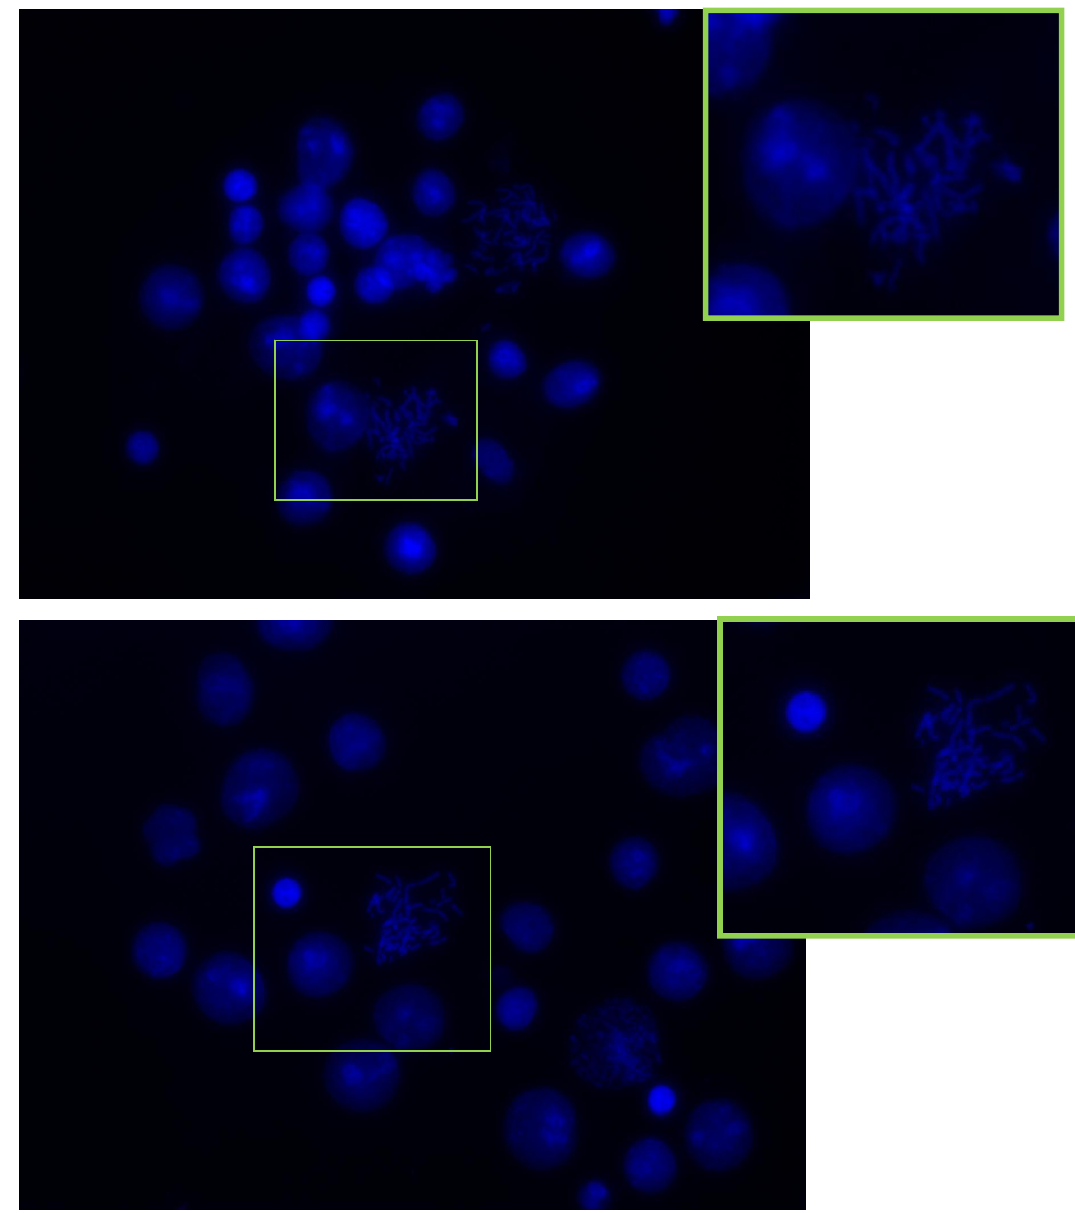
Figure 6. (a) (Top) Chromosome spreads prepared using the FISHprep device; (b) (Bottom) Chromosome spreads achieved using the manual dropping technique. Offset pictures present high magnification